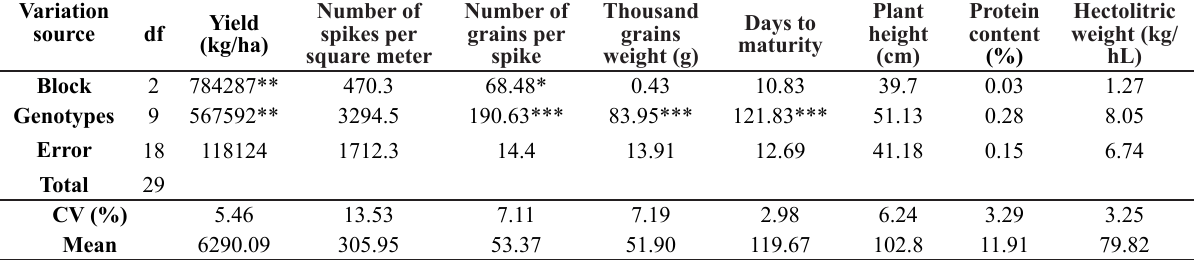
Table 5. Mean squares of the analysis of variance of grain yield, number of spikes per square meter, number of grains per spikes, thousand grains weight (g), days to maturity, plant height (cm), protein of grains (%) and hectolitric weight (kg/hL) of the drought experiment of the assessment of tolerant wheat genotypes ( Triticum aestivum L.) to drought under conditions of La Molina LM 2019B.